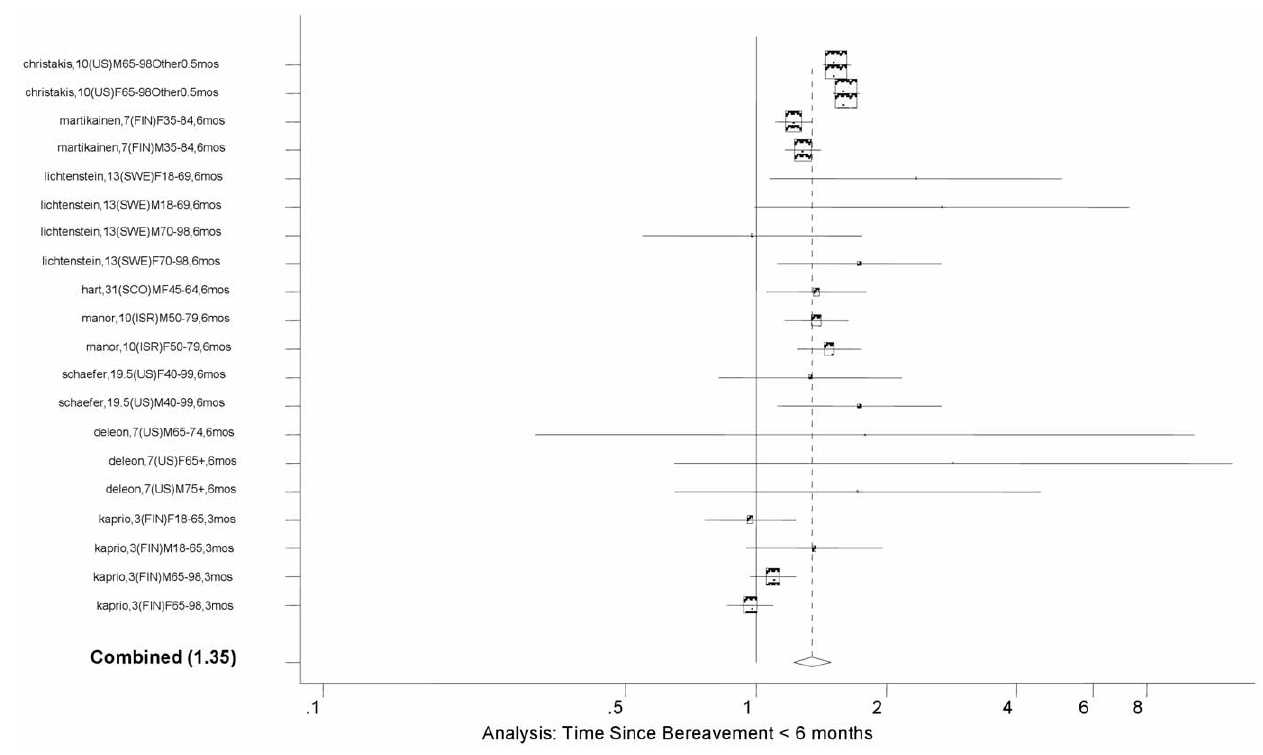
Figure 2. Forest Plot for Time Since Bereavement of , 6 months.